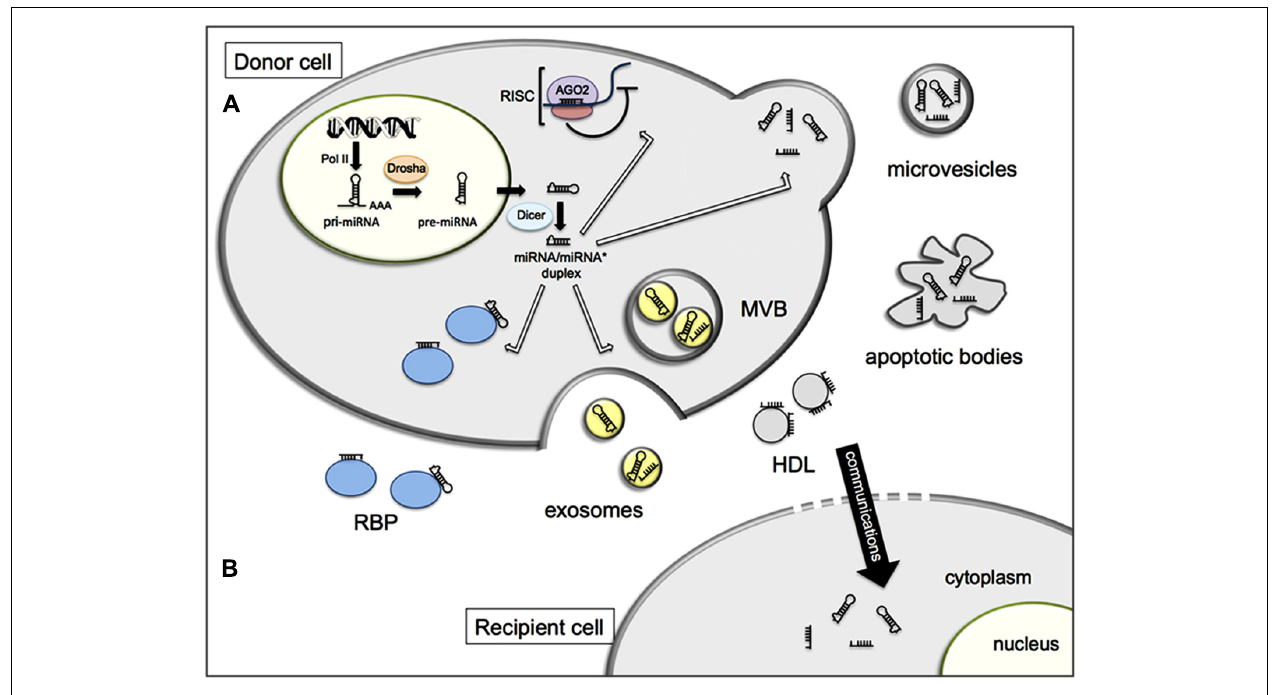
likely subject to degradation. Within the RISC complex, miRNAs bind to their target messenger RNAs (mRNAs) to repress their translation or induce their degradation. In addition, miRNAs can be exported out of the cells and transported by various carriers, membrane-derived vesicles (exosomes, microvesicles, apoptotic bodies), miRNA-binding protein complexes (RBP), or high density lipoproteins (HDL). (B) Extracellular miRNAs can be transferred to recipient cells where they alter gene